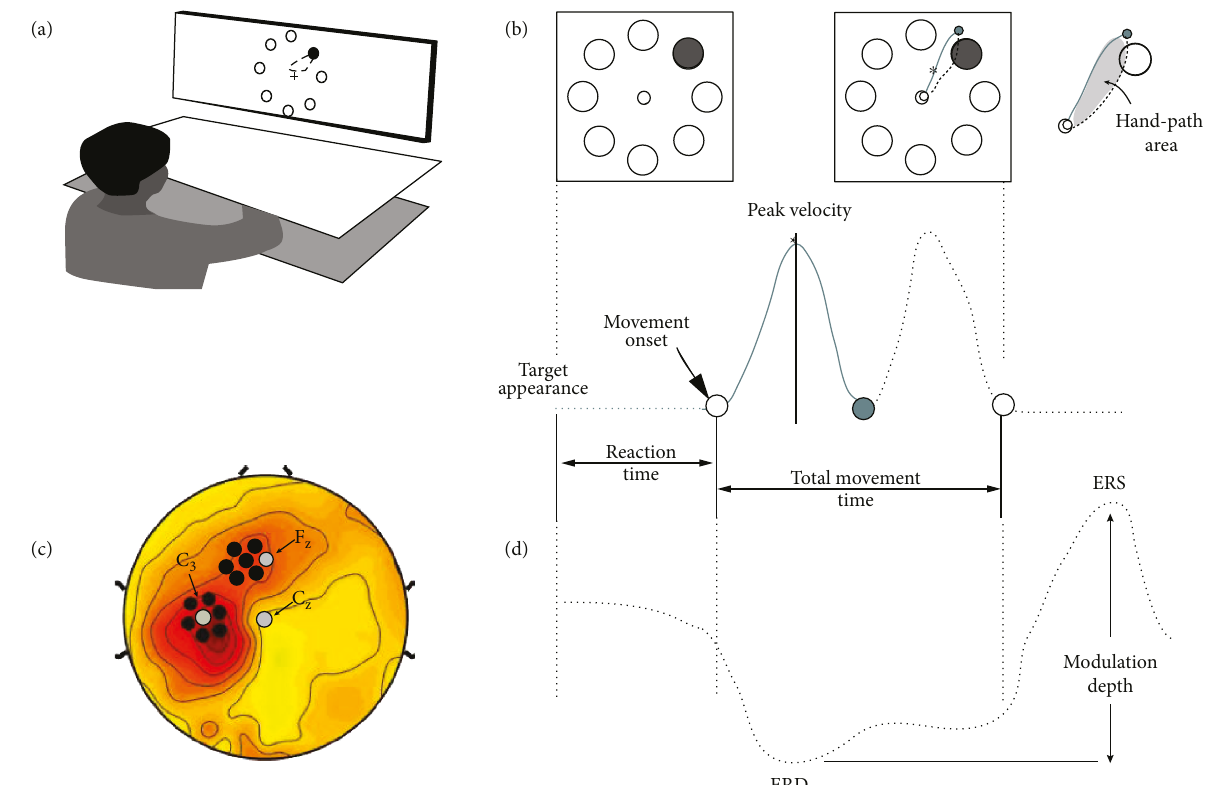
Figure 1: Experimental design and kinematic measures. (a) Testing set up. (b) Upper line: target display on the screen with the appearance of the target (left); the hand-path display during the movement (center); in grey, the hand-path area (left). Bottom line: temporal pro fi le of trajectory velocity with the kinematic parameters used in the analyses. (c) De fi nition of the regions of interest (ROIs): the left and the frontal ROIs (black dots) with Cz, Fz, and C3 (grey dots). (d) Representation of beta power changes related to target appearance, movement onset, and end. The peak of event-related desynchronization (ERD) is followed by a rebound (or event-related synchronization, ERS) after the movement end. Beta modulation is de fi ned as the di ff erence between ERD and ERS